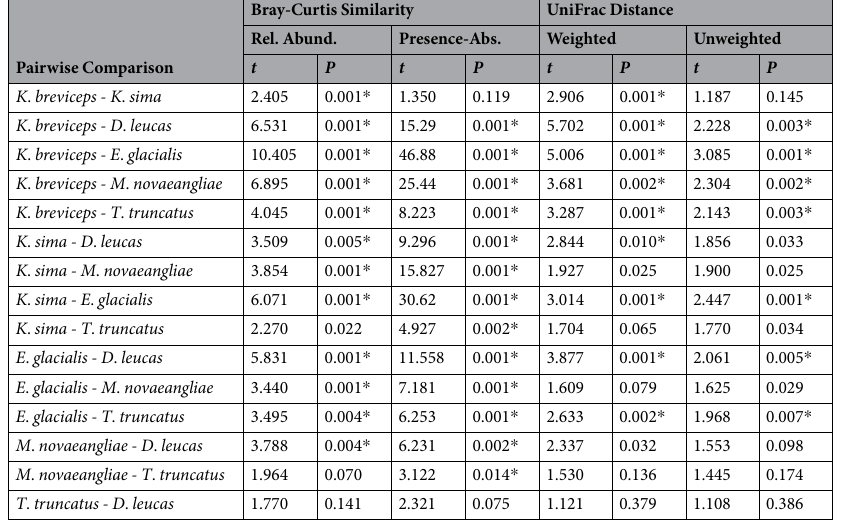
Table 1. Pairwise statistical comparisons of microbial community structure (PERMANOVA) across cetacean hosts, based on OTU-dependent (Bray Curtis) and OTU-independent (UniFrac) metrics of relative abundance (Rel. Abund., Weighted) and presence-absence (Presence-Abs., Unweighted) data. Asterisks ( * ) indicate significant differences following B-Y corrections.